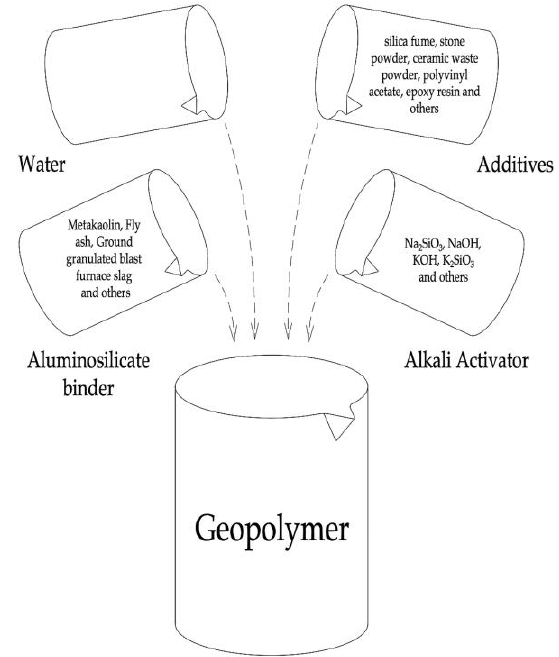
Figure 1. The main components of the geopolymer composition.